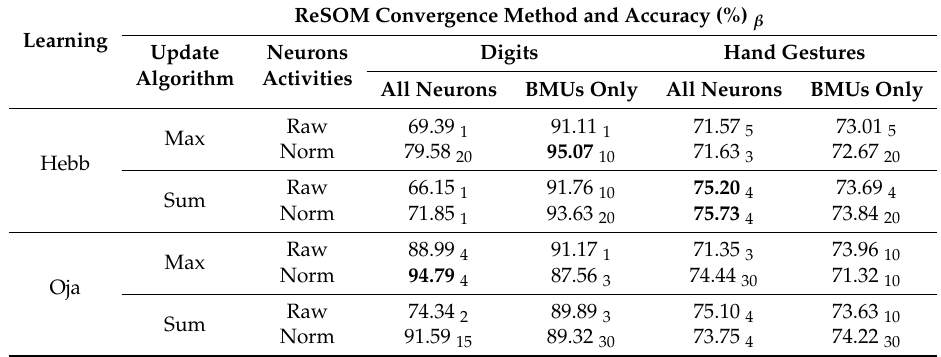
Table 3. Multimodal classification accuracies (bold number represent the best results in the table).